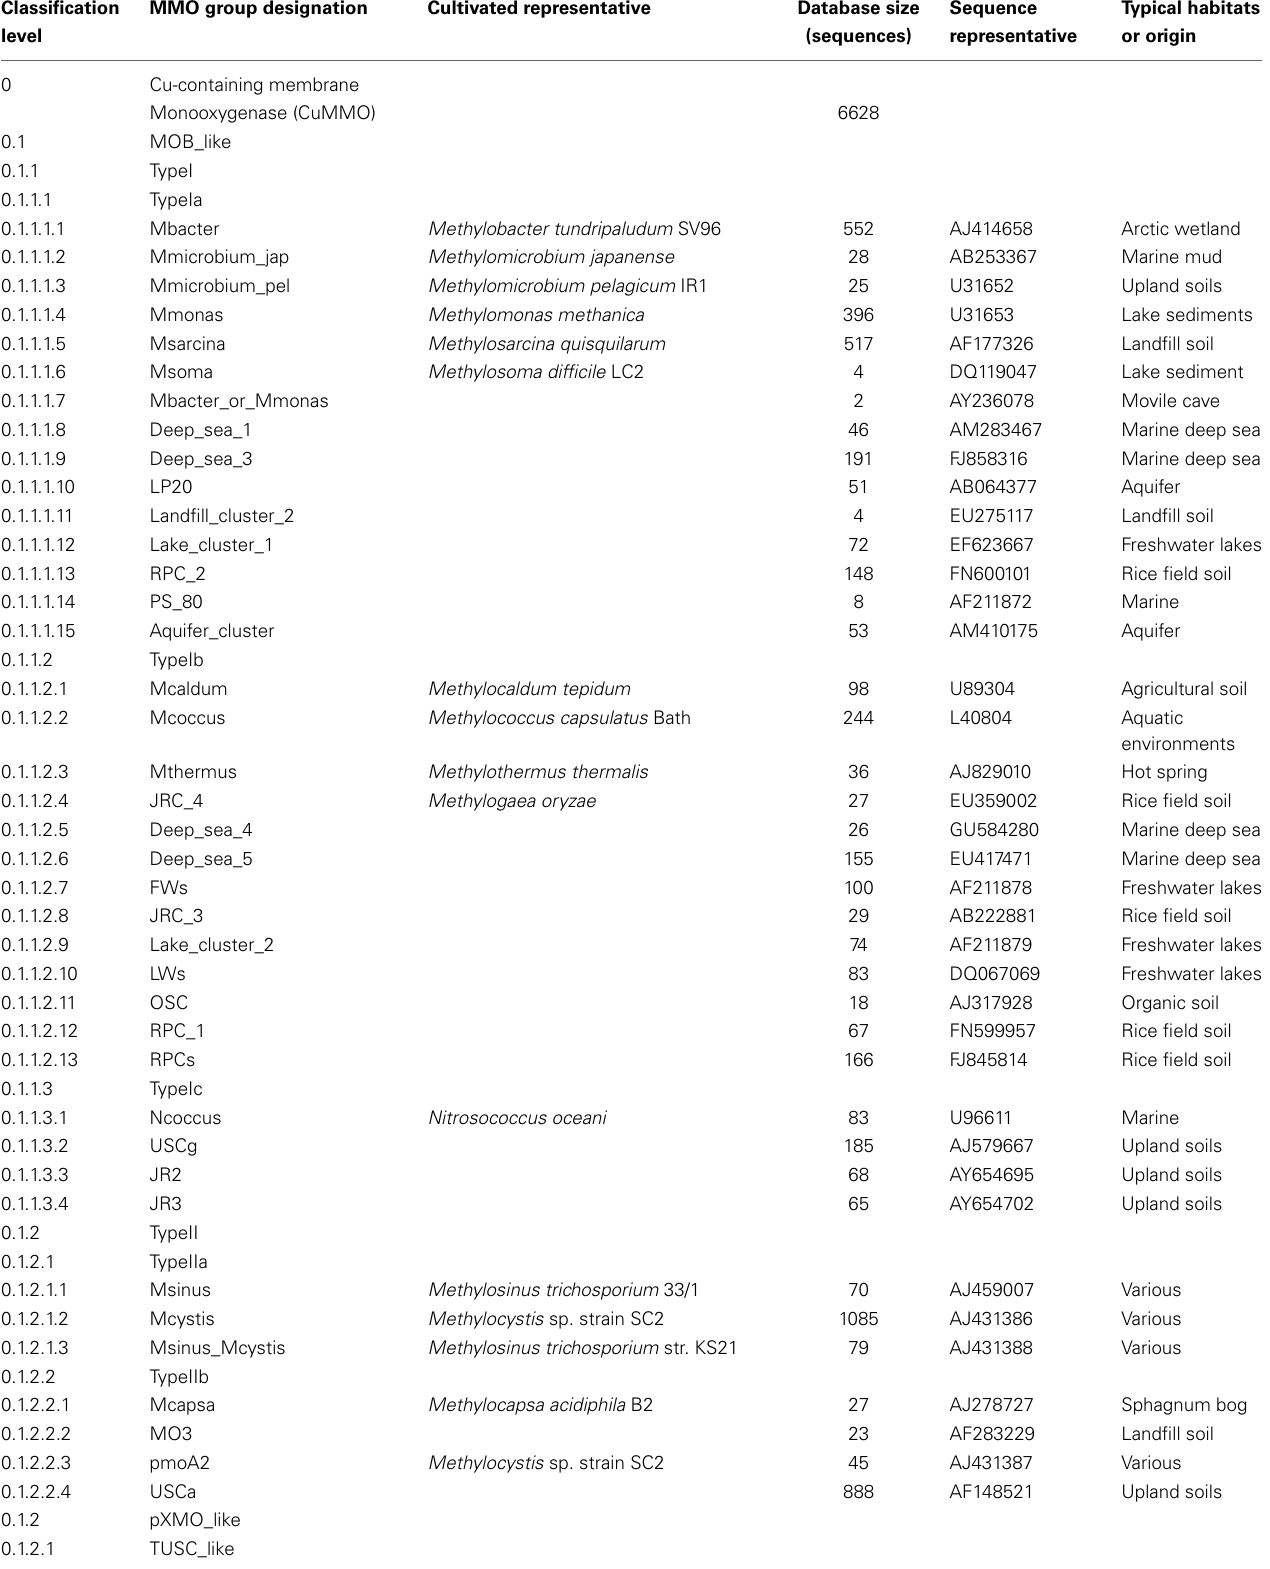
Table 1 | Description of the pmoA